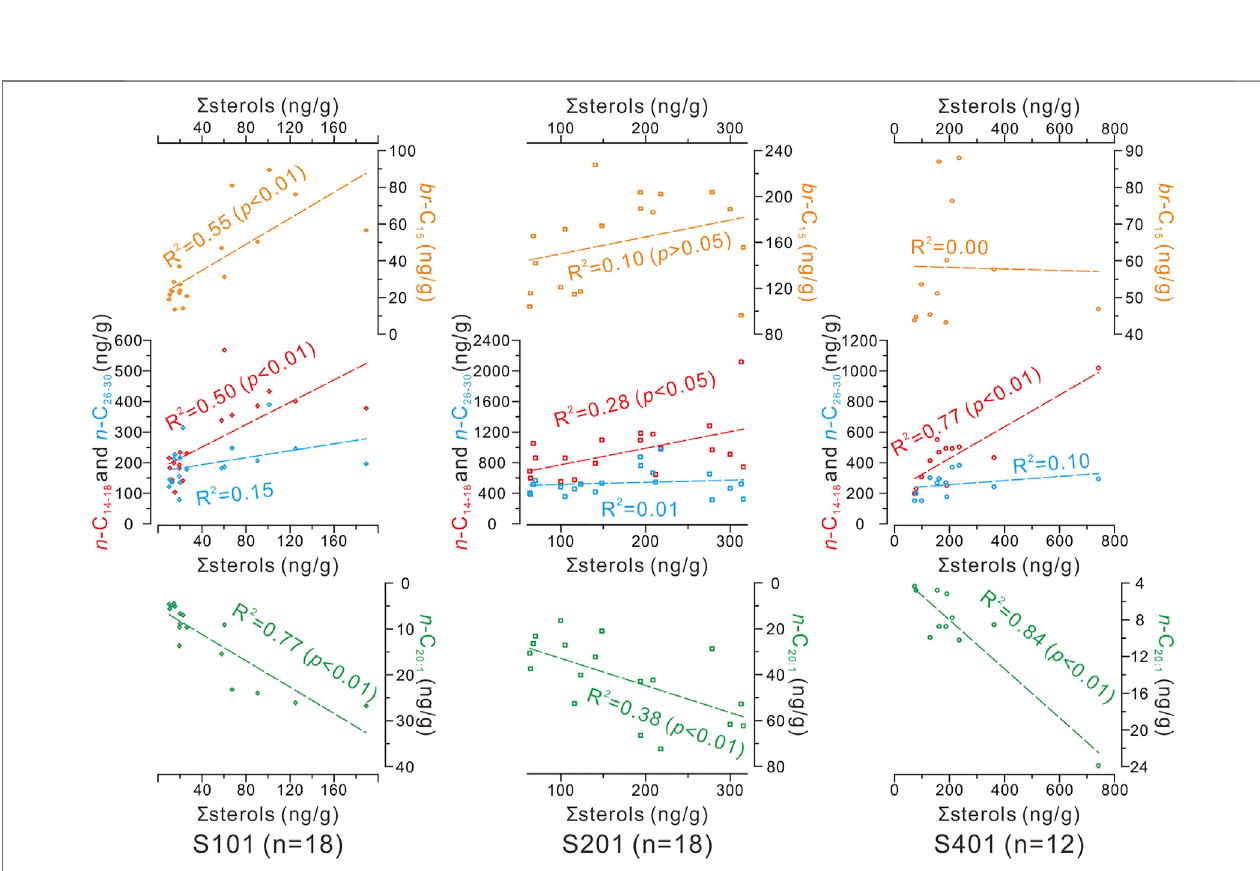
FIGURE 5 | Linear correlation of (cid:4) sterols with n -C 14 – 18 (red points), n -C 26 – 30 (blue points), n -C 20:1 (green points) and br -C 15 (orange points) alcohols in the three cores.